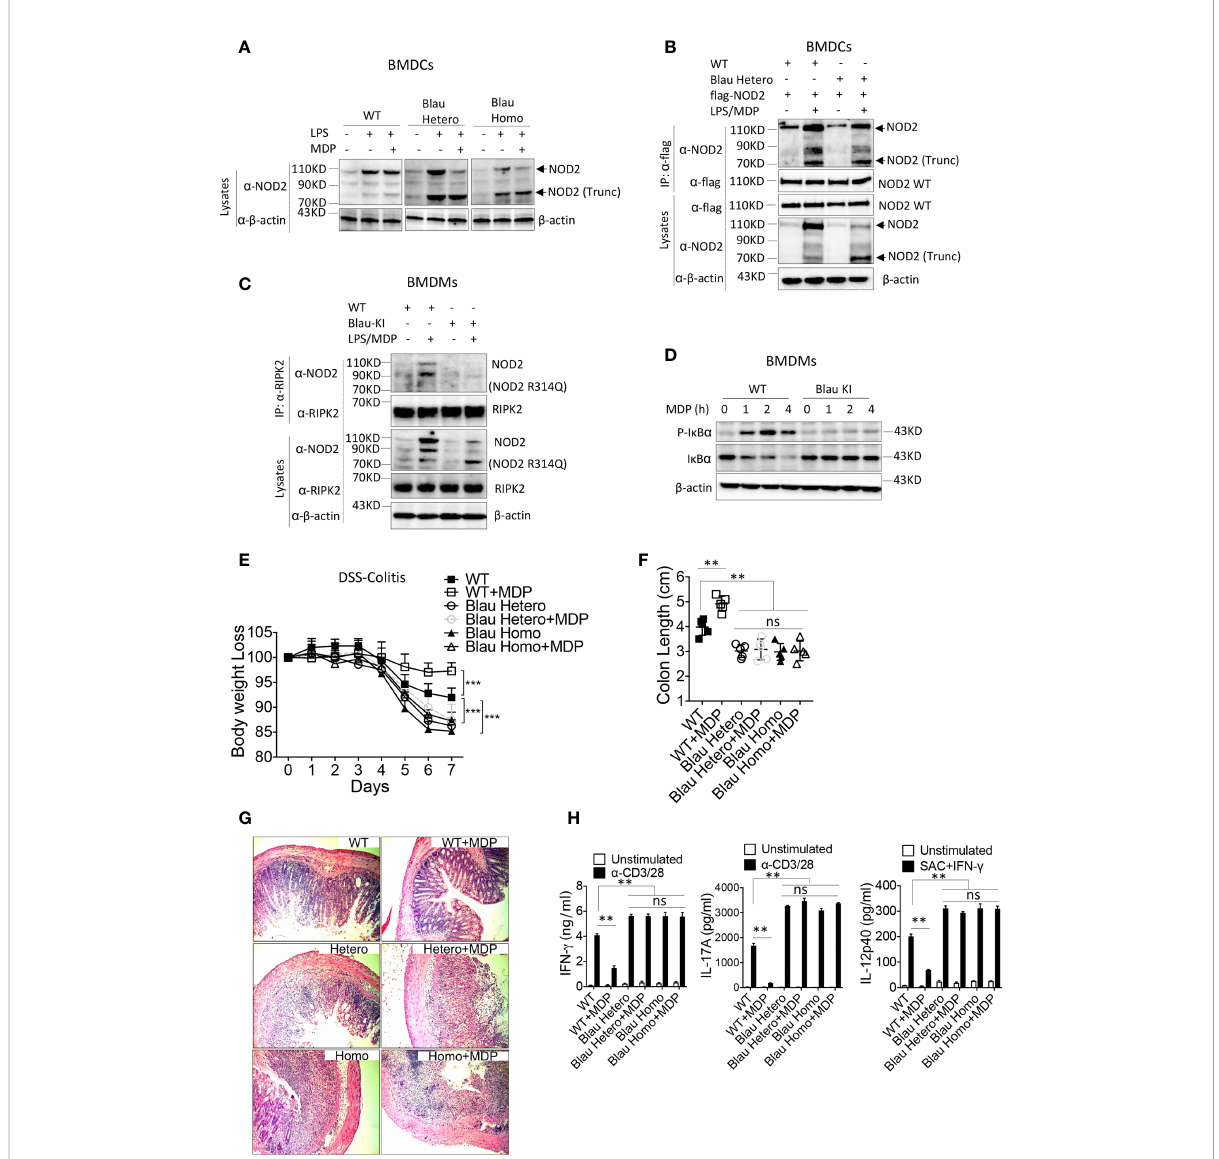
FIGURE 6 NOD2 bearing a BS mutation expressed on one allele binds to intact NOD2 and exerts a dominant negative effect on intact NOD2 expressed on the other allele of BS-KI heterozygous mice. (A) BMDCs from WT mice, heterozygous Blau KI mice or homozygous Blau KI mice were stimulated with LPS (200ng/ml) only or LPS (200ng/ml) plus MDP (50ug/ml) for 6 hours, the cells were lysed, and the cell lysates were then subjected to Western blot for NOD2 detection. (B) Bone marrow derived dendritic cells (BMDCs) from WT mice or heterozygous Blau-KI mice were transfected with a plasmid expressing fl ag-tagged wild type mouse NOD2 as indicated; 48 hours later the cells were primed with LPS (200ng/ml) for 5 hours and then stimulated with MDP (50 m g/ml) for 1 hour; the cells were then lysed and the cell lysates were subjected to IP with anti- fl ag antibody and then Western blot for detection of NOD2 binding forms of endogenous NOD2. (C) BMDMs from Blau KI mice or their wildtype littermates were primed with LPS (200ng/ml) for 5 hours and then MDP (50 m g/ml) for 1 hours; the cells were then lysed, and the lysates obtained were subjected to IP with anti-RIPK2 antibody and Western blotting for detection of NOD2. (D) BMDMs described in (C) were incubated with MDP (20 m g/ml) for various time periods after which the cells were then lysed and the lysates obtained were subjected to Western blotting for detection of I k B a phosphorylation and degradation. (E) DSS-colitis associated weight loss of C57BL/6 heterozygous (n=5) or homozygous (n=5) Blau KI mice and their wild type littermates (n=5) treated with 4% DSS in drinking water; mice were administered muramyl dipeptide (MDP, I00 m g/mouse, IP, n=5) or PBS (n=5) on days 0-5 and were harvested for analysis on day 7. (F) Colon length from mice harvested on day 7 after DSS-colitis induction. (G) Representative histology of colons after H&E staining of colonic tissue from mice harvested on day 7 after initiation of DSS-colitis induction. (H) TCR-induced production of IFN- g and IL-17A and SAC+IFN- g -induced IL-12p40 production by extracted MLN cells from mice harvested on day 4 were examined by ELISA. Data in (A – D) are representative of three independent experiments. Data in (E) were analyzed using a two-way ANOVA with Dunnett ’ s multiple comparisons and are displayed as mean ± SEM; ***p<0.001. Data in (F, H) were analyzed using a two-way ANOVA with Tukey ’ s multiple comparisons and are displayed as mean ± SEM; **p<0.01; ns: not signi fi